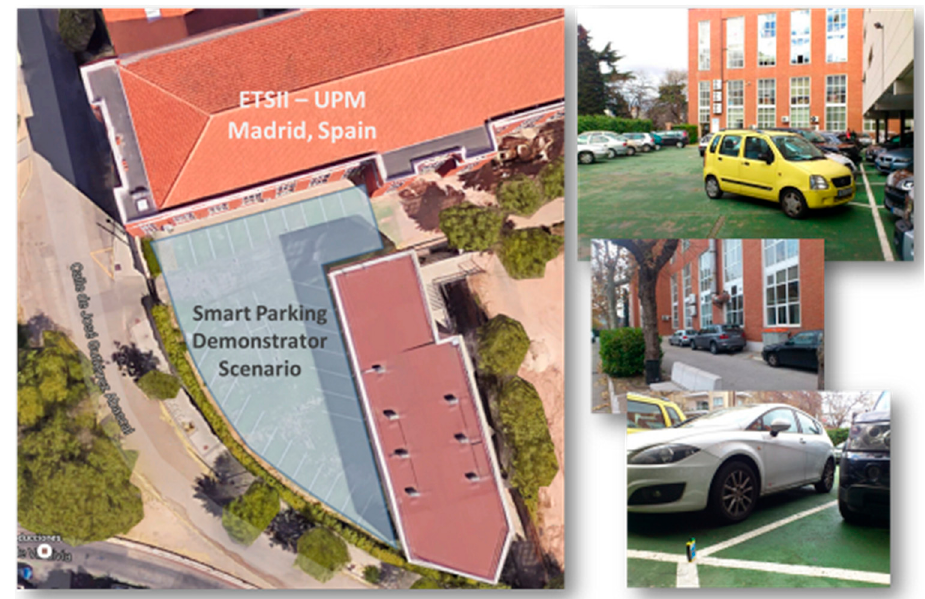
Figure 23. Application scenario for the smart parking demonstrator.